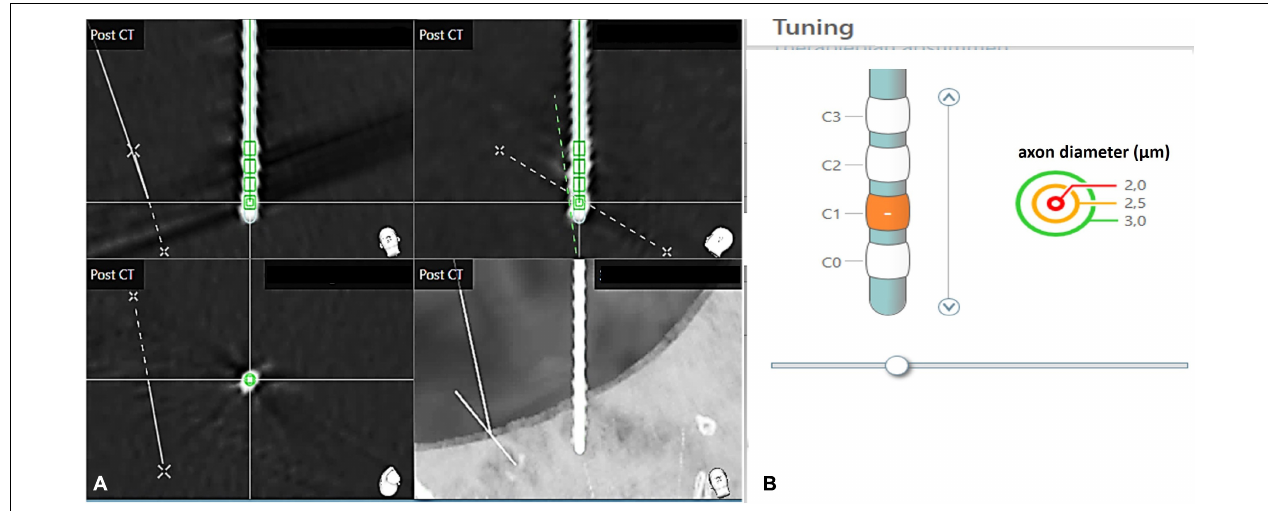
FIGURE 1 | Methodological approach of electrode localization within the SureTuneTM software. After definition of the AC-PC line in the axial and sagittal plane in the merged CT and MRI images, determination of spatial parameters of electrode localization was performed (A) . Definition of active contact and modeling of volume of tissue activated by using corresponding stimulation parameters (B)